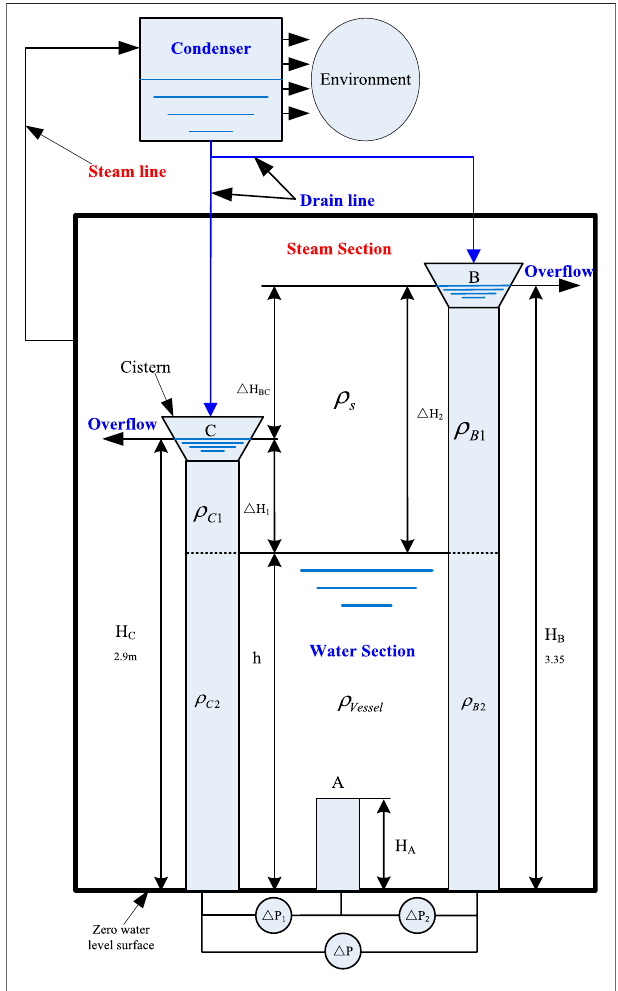
FIGURE 3 | Scheme of inside vessel double-reference-tube water level